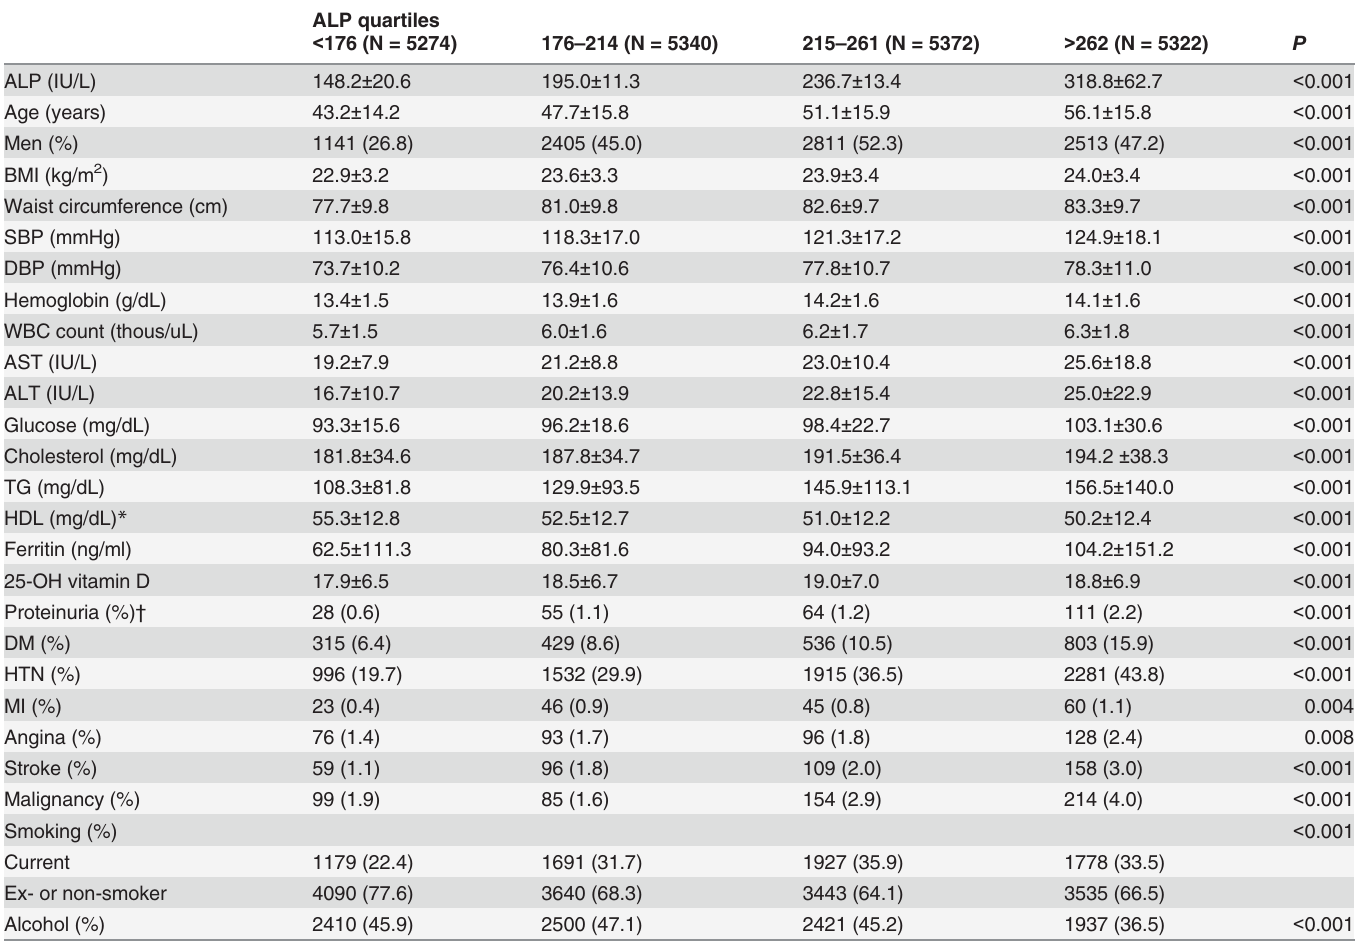
Table 1. Baseline characteristics stratified by serum alkaline phosphatase (ALP) quartiles. ALP quartiles < 176 (N =